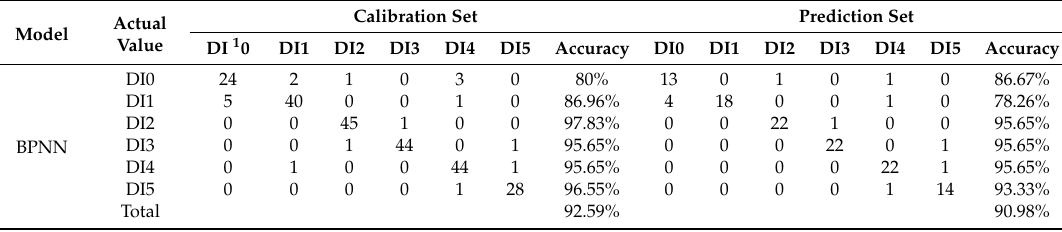
Table 2. Detection accuracy of infestation degrees by the BPNN model based on characteristic